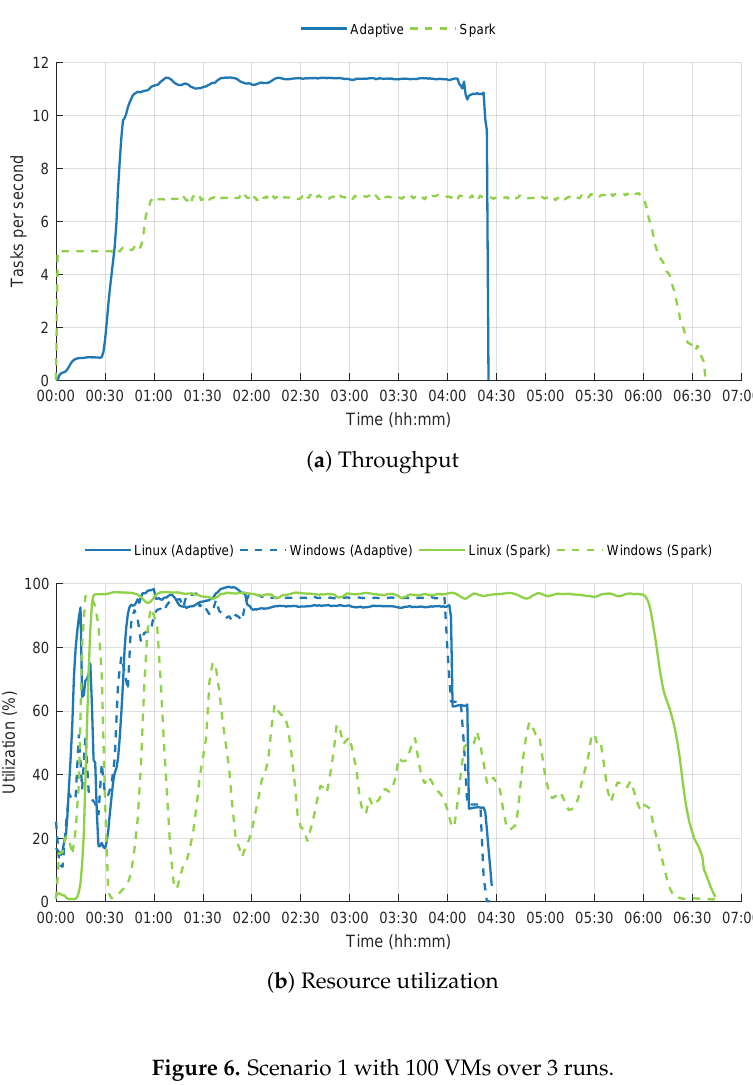
Figure 6. Scenario 1 with 100 VMs over 3